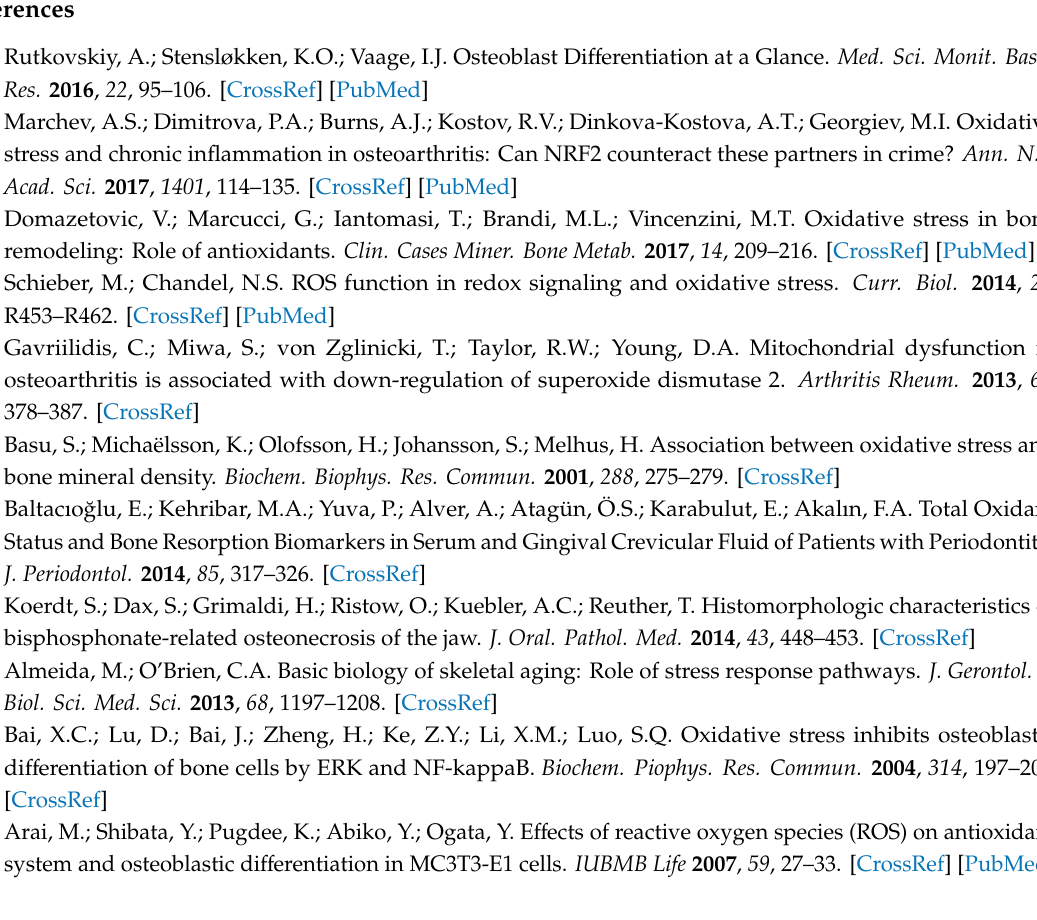
Supplementary Materials: The following are available online, Table S1: The level of proteins with transporter or transcription regulator activity that expression was significant changed in osteoblasts treated with H2O2 (200 µ M for 24h) and vitamins K1, MK4, or MK7 (10 µ M for 5 days), Table S2: The level of proteins with transporter or transcription regulator activity that expression was significant changed in osteoblasts treated with H2O2 (200 µ M for 24h) and vitamins K1, MK4, or MK7 (10 µ M for 15 days), Table S3: The level of proteins with transporter or transcription regulator activity that expression was significant changed in osteoblasts treated with H2O2 (200 µ M for 24h) and vitamins K1, MK4, or MK7 (10 µ M for 20 days), Table S4: The p values of proteins expression obtained basing on label-free quantification in osteoblasts treated with H2O2 (200 µ M for 24h) and vitamins K1, MK4, or MK7 (10 µ M for 5, 15, 20